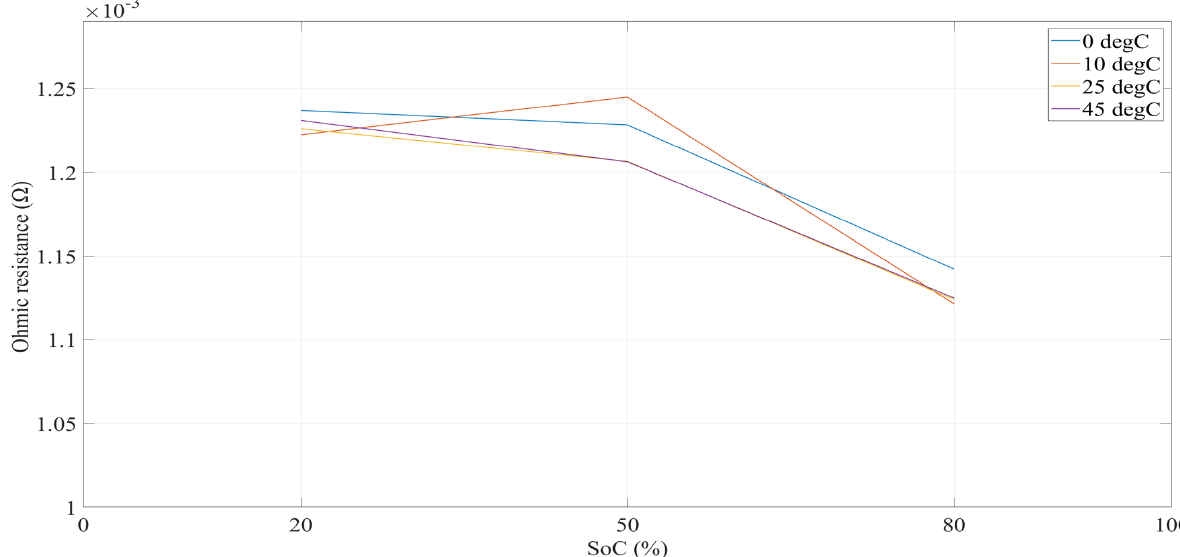
Figure 3. The corresponding region of the pulse and the schematics of the electrical model.